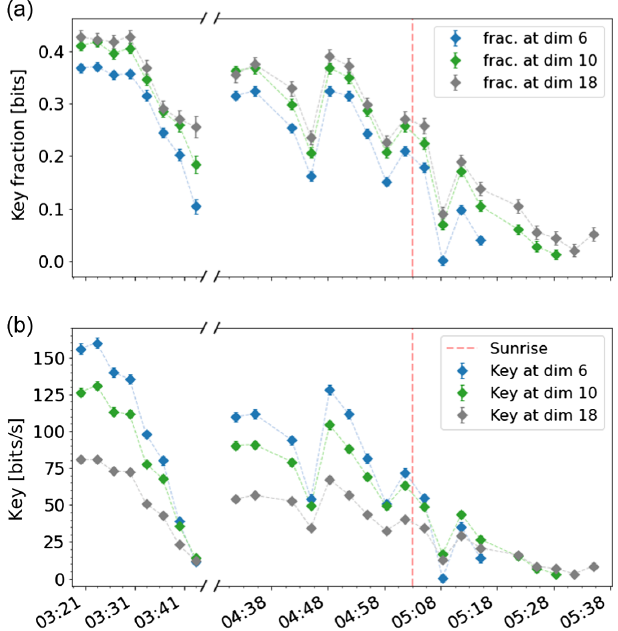
FIG. 4. Key rate versus key fraction. A closer look at